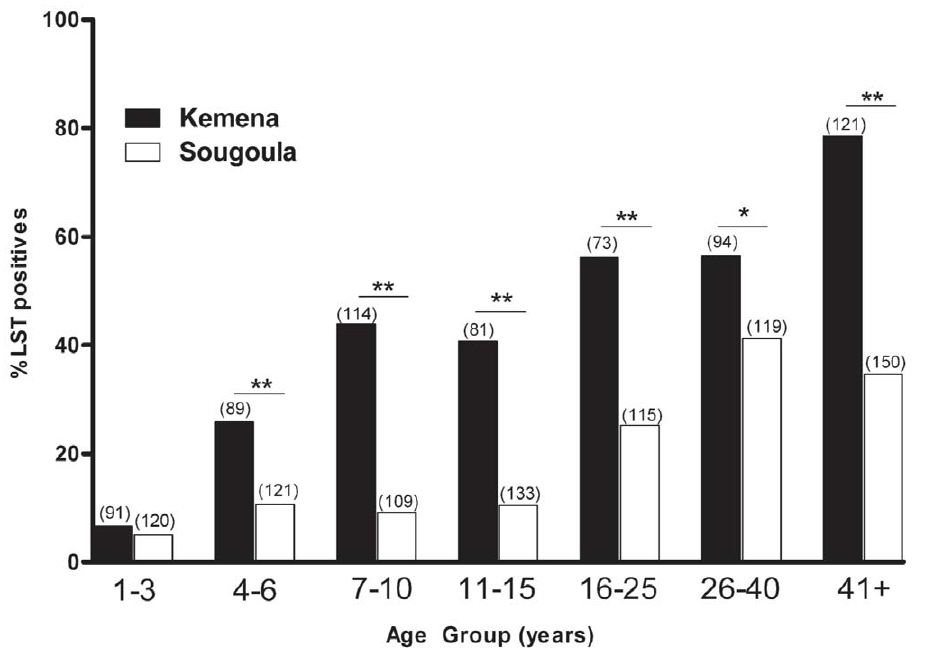
Figure 2. Prevalence of Leishmania infection by age group. Frequency of LST-positive individuals from Kemena (black bars) and Sougoula (white bars) by age group. The numbers in parenthesis represent the total number of individuals in each age group. Asterisks indicate statistical significance (* P , 0.005 or ** P , 0.001). doi:10.1371/journal.pntd.0000565.g002 by household for Kemena (Figure 4A) and Sougoula (Figure 4B) for the combined incidence data of 2007 and 2008. Yellow circles represent population by household, and red circles represent LST + individuals. Spatial analysis determined that there is no geographical clustering of LST + individuals within either village.